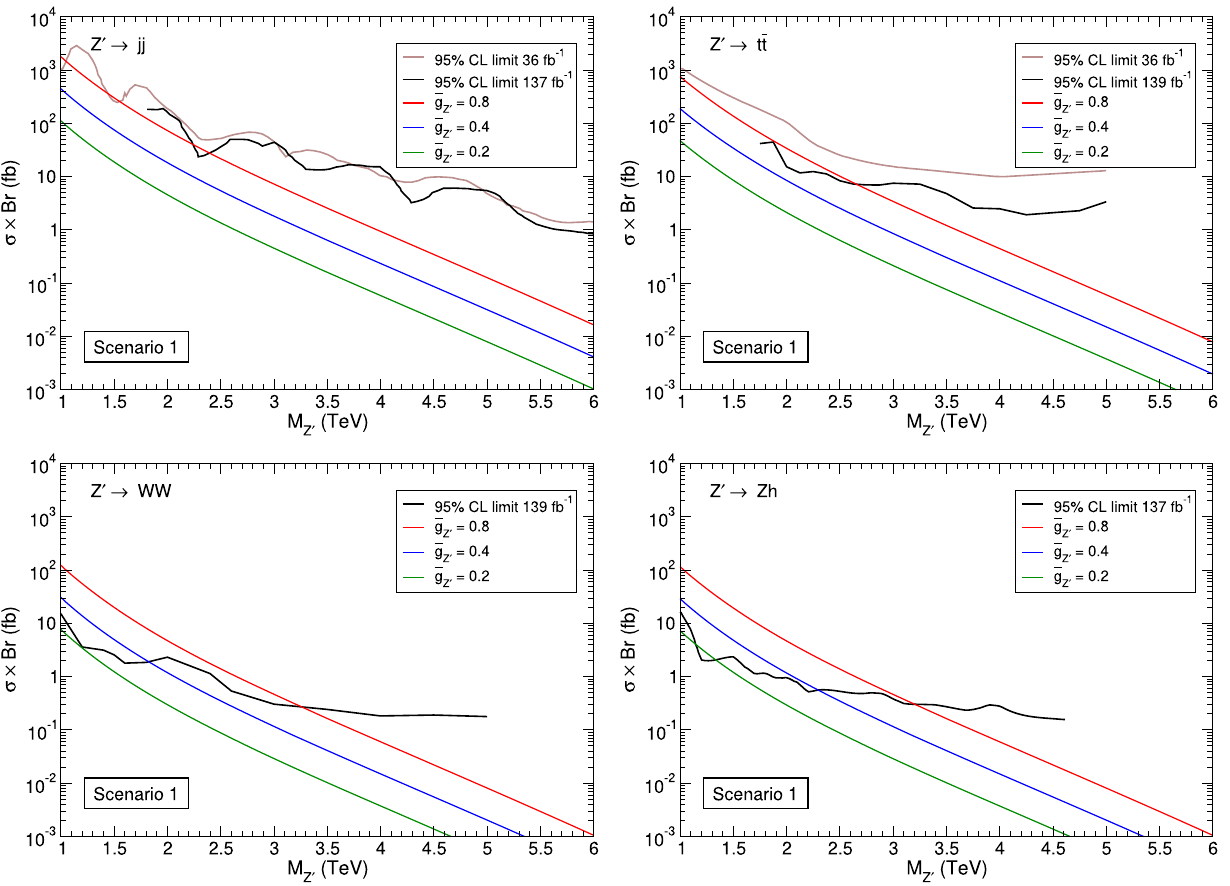
Fig. 3 Limitson Z (cid:2) bosonsarisingfromsearchesinseveralfinalstates: dijets [63,73] (top left), t ¯ t [64,74] (top right), WW [65] (bottom left) and Zh [66] (bottom right). Together, we show the cross section pre-